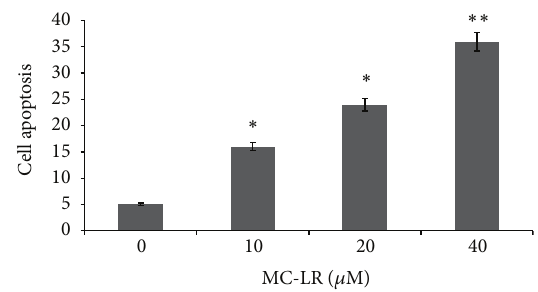
Figure 2: The MC-LR inhibited apoptosis in HUVECs. Data are expressed as the mean values ± standard deviation of at least three independent experiments. Representative microphotographs are shown. ∗ 𝑝 < 0.05 and ∗∗ 𝑝 < 0.01 versus control ( 𝑛 = 3 independent